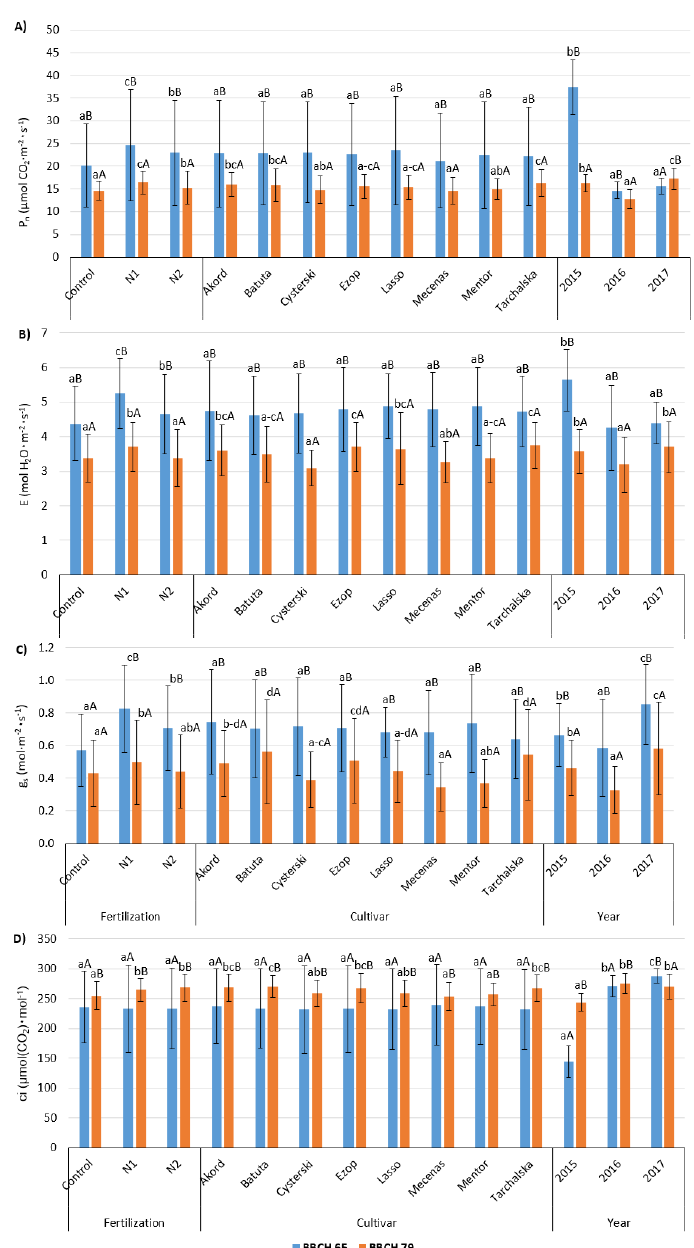
Figure 4. Effect of interaction of foliar fertilization and years in shaping gas exchange parameters in pea bracts: ( A ) intensity of photosynthesis net (P n ); ( B ) transpiration rate (E); ( C ) stomatal con- ductance (g s ); ( D ) intercellular CO2 concentration (Ci). N1 − fertilizers/biostimulators of plant origin, N2 − biostimulants of animal origin. Error bars are standard deviations of the means. Different letters above the columns indicate significant difference between treatments: small for fertilization and capital for measurement terms (ANOVA, Tukey test) at p <